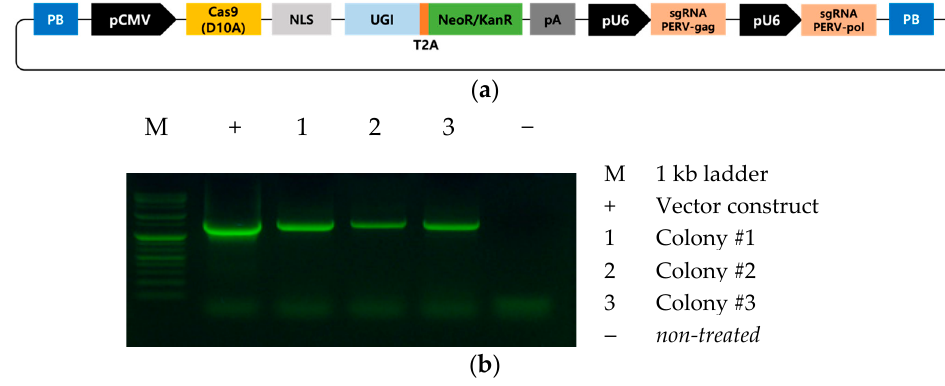
Figure 1. Target-AID vector system used in the study. ( a ) Scheme of the PB-CMV-Target-AID- PERV( pol - gag ) vector used in this study. ( b ) PCR analysis of the target AID vector integration in porcine fibroblasts.